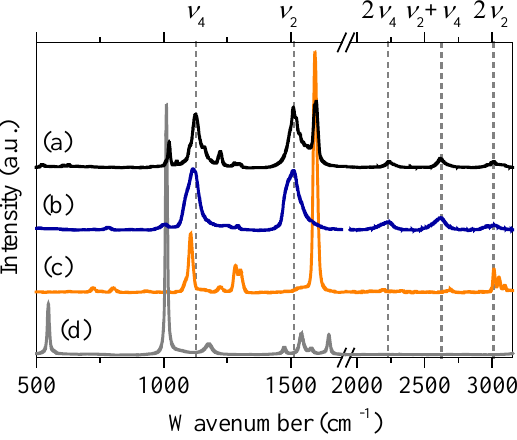
Figure 10. Raman spectra with 532 nm excitation of ( a ) DIBD–UIC after irradiation at 254 nm; ( b ) trans –(CH) x ; ( c ) crystalline DIBD; and ( d ) tetragonal urea [86]. The ν n values at the top are the mode frequencies for polyacetylene fundamental transitions and their overtones.